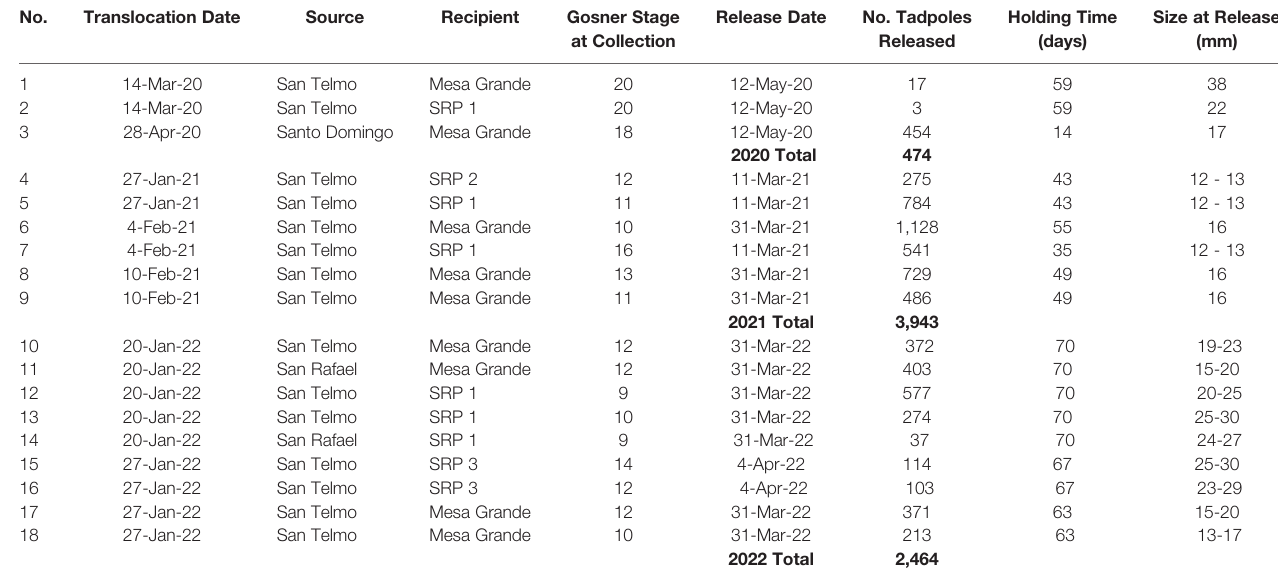
TABLE 3 | Headstarting results for 18 R. draytonii half-egg masses translocated from Baja California, Me ́ xico, to California, U.S.A. (2020 – 2022).